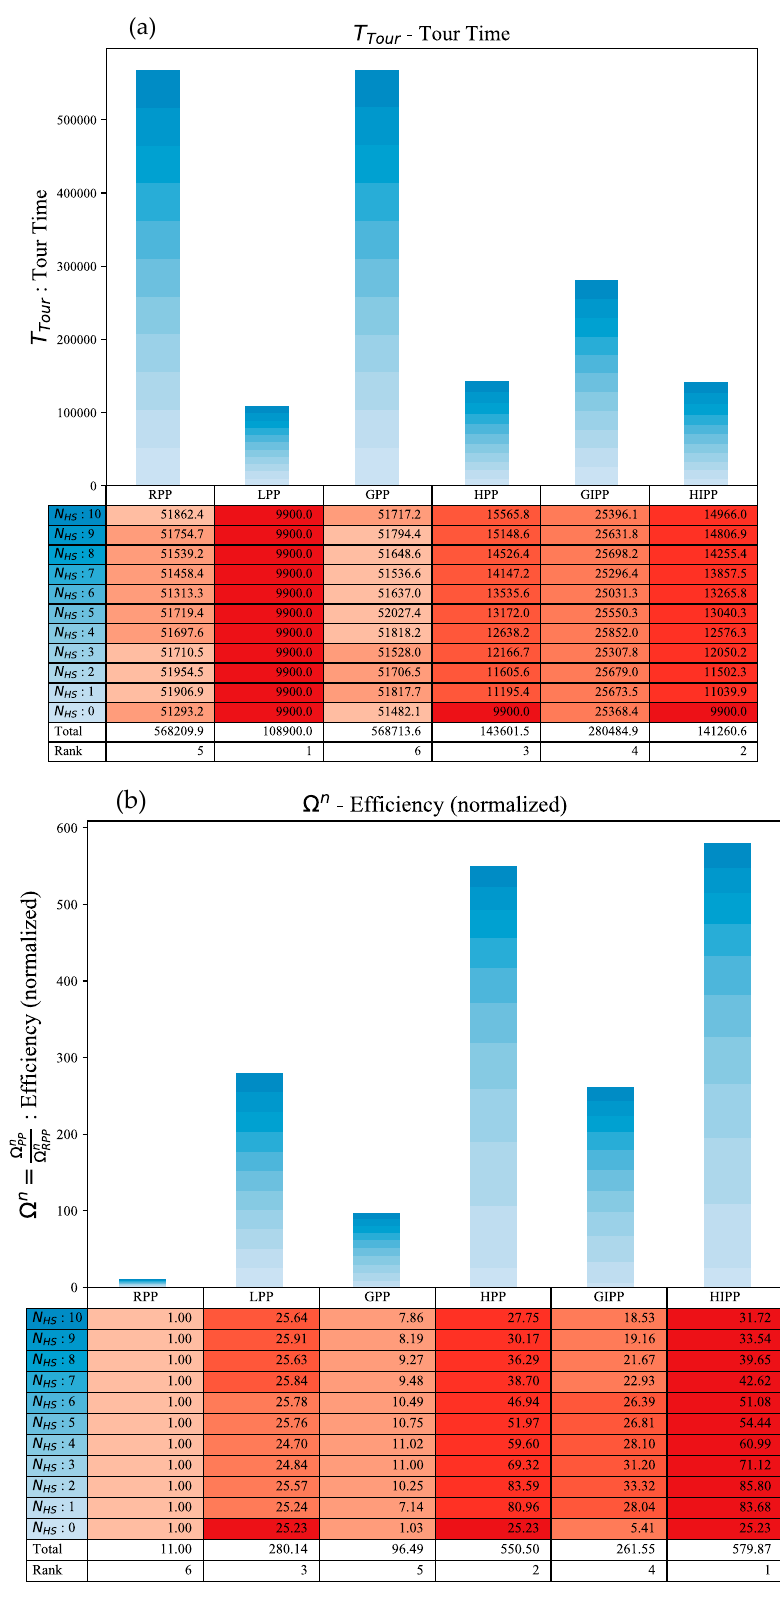
Figure 6. Comparative analysis for T tour & Ω : ( a ) The top stacked bar graph is for time to complete the tour T tour ; ( b ) The bottom stacked bar graph is for the efficiency measure Ω